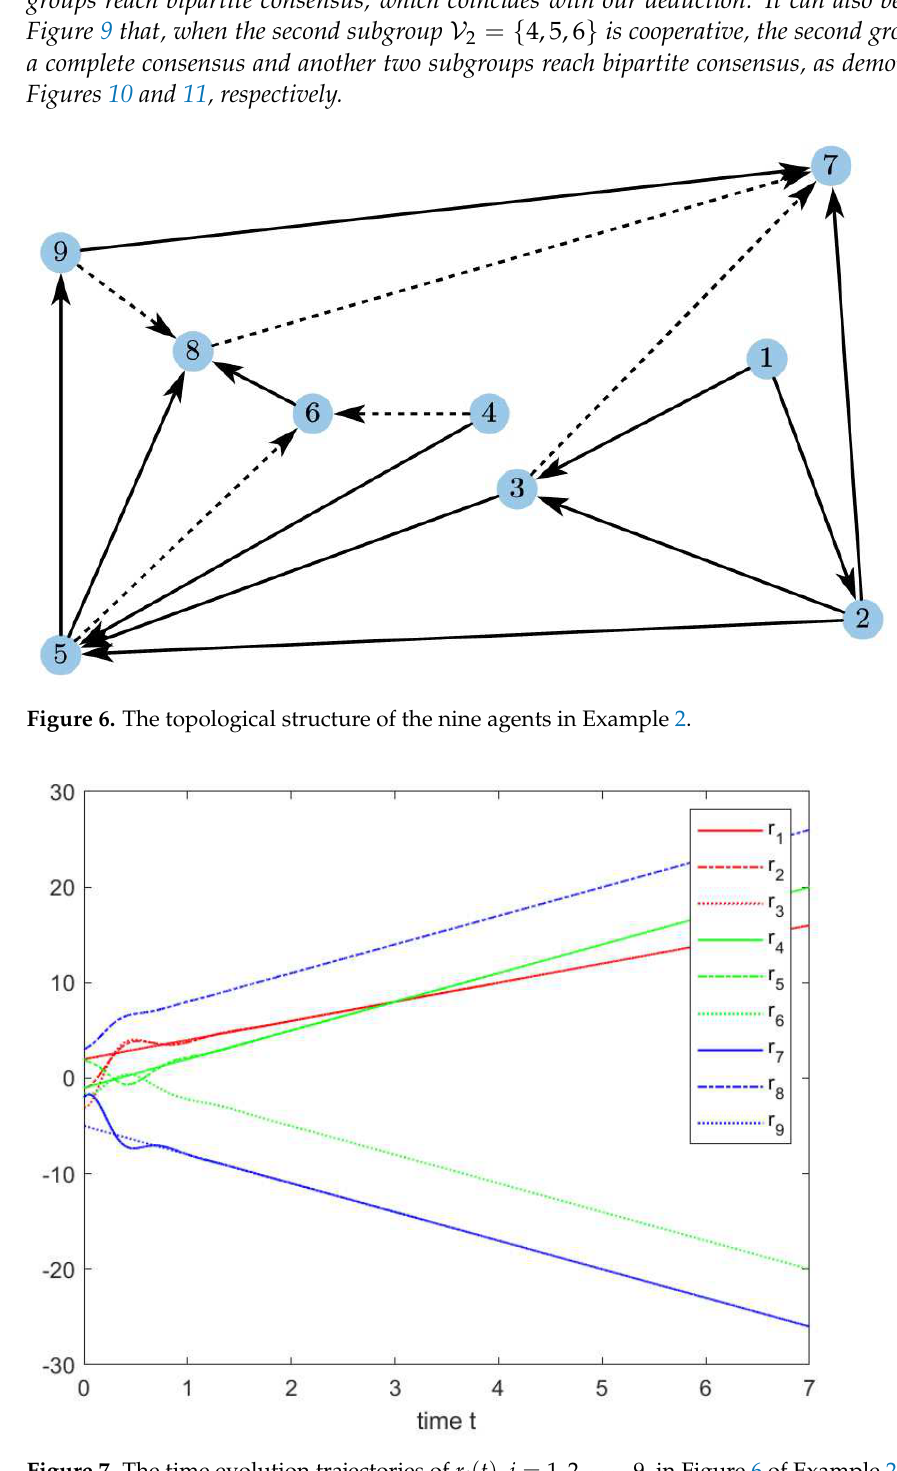
Figure 7. The time evolution trajectories of r i ( t ) , i = 1,2, · · · ,9, in Figure 6 of Example